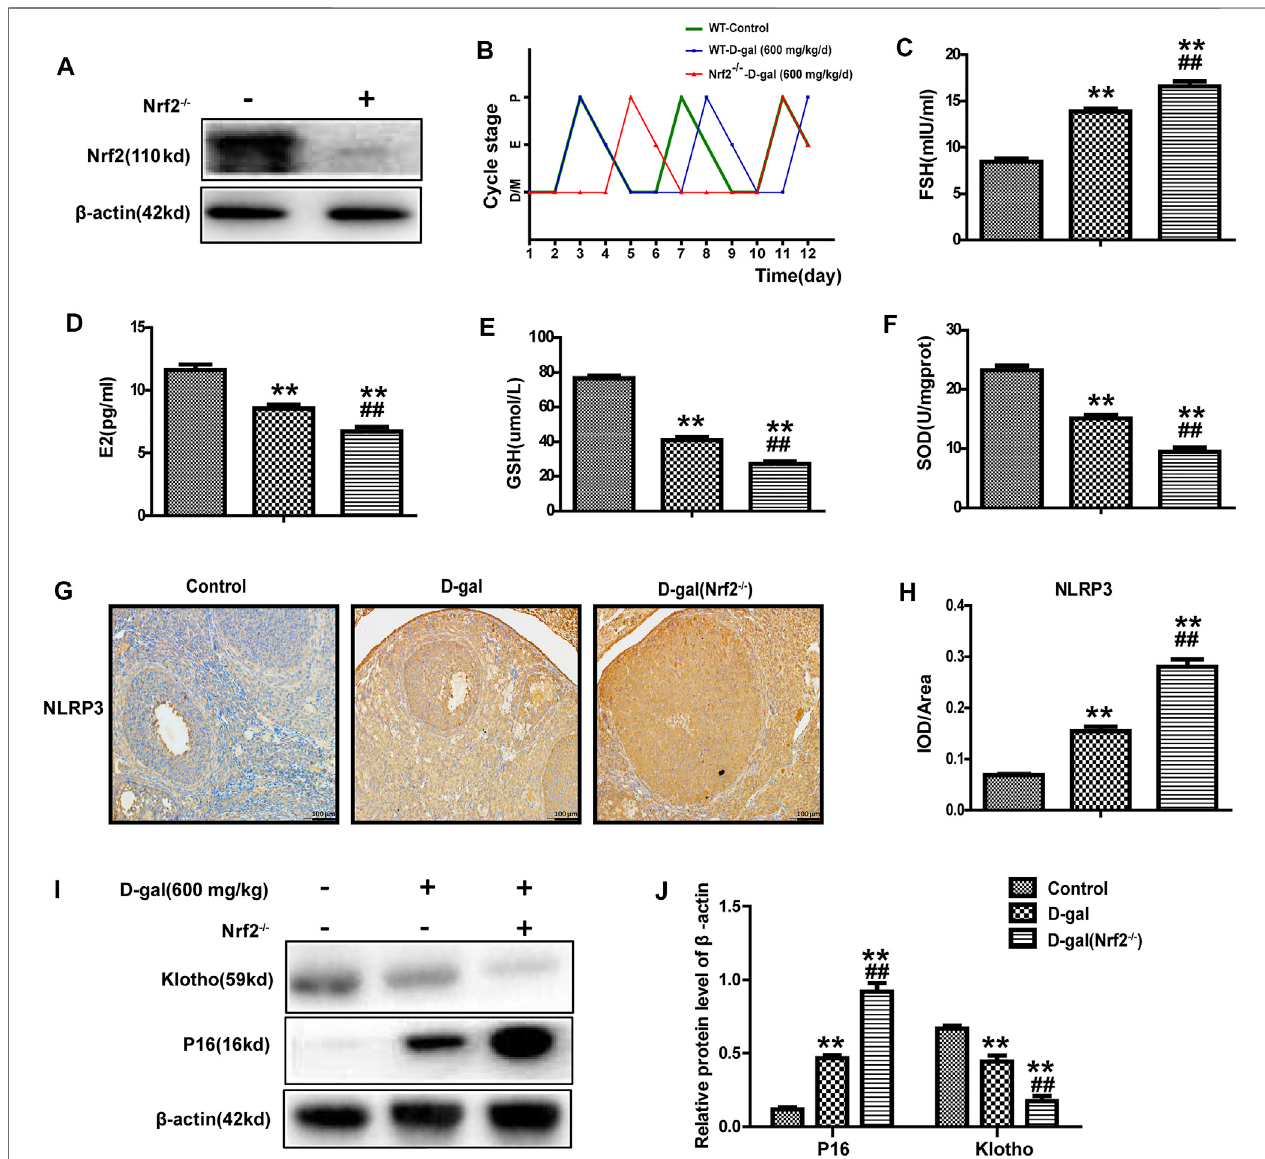
FIGURE2 | Nrf2 knockout signi fi cantly damaged theovarian function and antioxidant capacity ofPOF mice. (A) Immunoblotting analysis ofNrf2 protein. (B) Using vaginal cytology evaluating the oestrous cycle and days spent in pro-oestrus (P), oestrus (E), metoestrus (M), and dioestrus (D) over the course of 12 consecutive days. (C,D) The serum FSH and E2 levels were tested. (E,F) The levels of GSH and SOD in ovarian tissues. (G,H) NLRP3 protein expression was analyzed after immunohistochemistry. (I,J) The level of P16 and klotho were analyzed. The data in B-H are shown as means ± SEMs, n = 5. The data in A, I-J are shown as means ± SEMs, n = 3. Statistical signi fi cance: ** p < 0.01, ## p < 0.01.